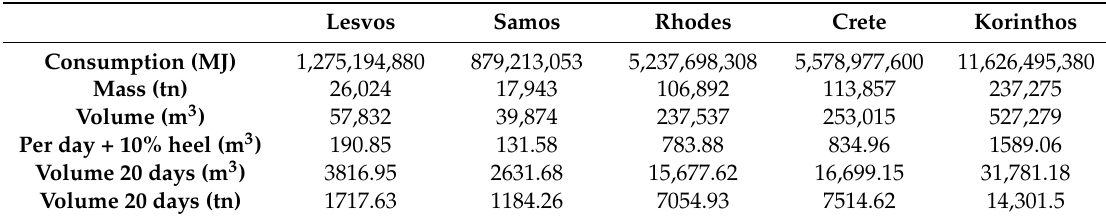
Table 5. The annual fuel consumption and the LNG